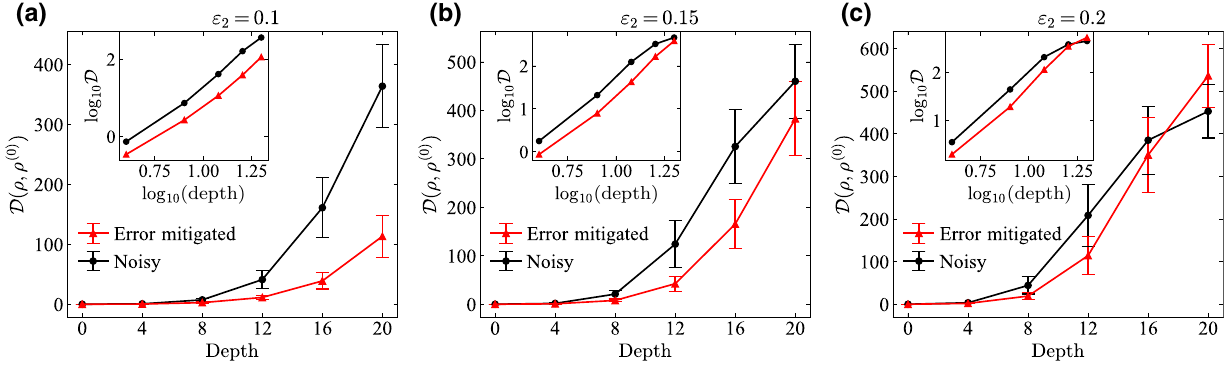
FIG. 10. Distance between ρ from noisy or error-mitigated circuits without global noise and ρ ( 0 ) from ideal circuits for different ε 2 . The system size is N q = 20 and we take the logarithmic in the